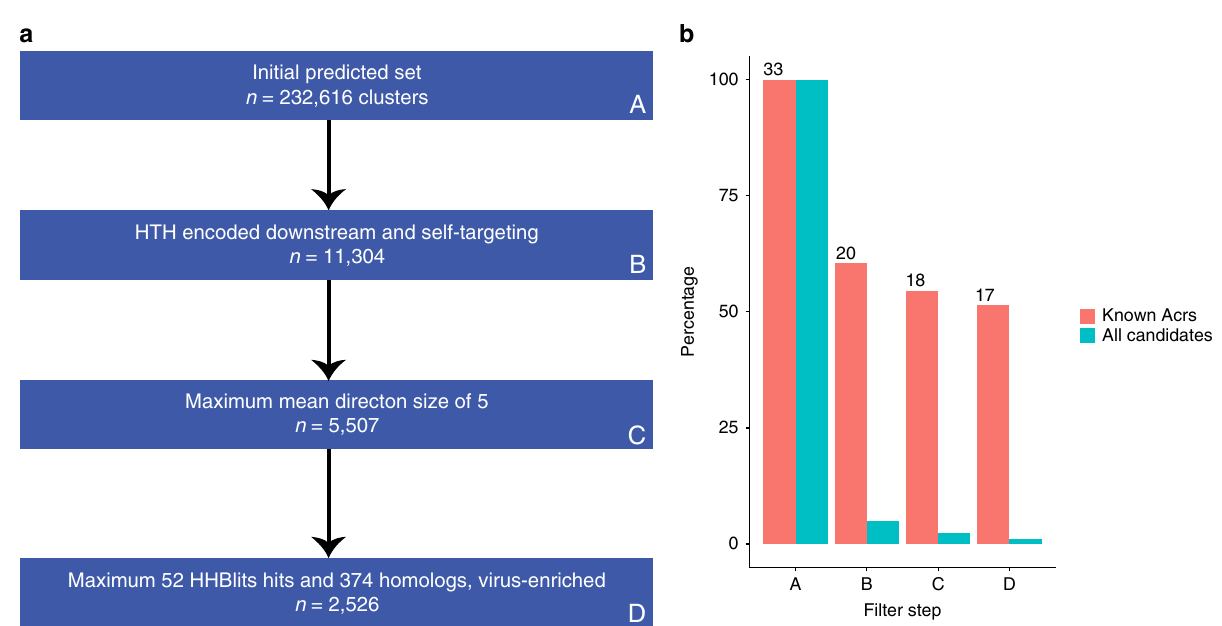
Fig. 3 Heuristic fi ltering of the Acr candidates. a Flowchart illustrating the heuristic fi ltering steps. The initial set consisted of 232,616 clusters and was fi rst fi ltered for clusters that included at least one member with an HTH-domain-containing protein encoded downstream, and at least one member from a self-targeting genome, two hallmark Acr characteristics 20 . Four additional fi lters were applied, for mean directon size, number of HHBlits hits, number of homologs, and enrichment for virus homologs. The thresholds were set based on the data presented here. b Bar plot indicating the percentage of candidates and known Acrs from the initial positive set at each fi ltering step. The red bars denote the percentage of Acrs remaining at each step, and the blue bars denote the percentage of all candidates remaining at each step. The raw numbers of remaining known Acrs from the initial positive set are displayed above each red